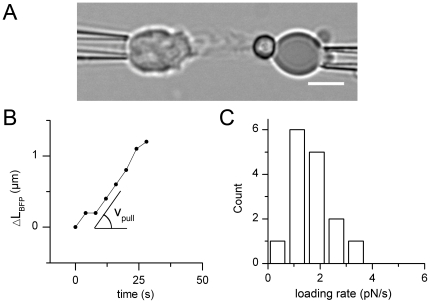
Characterization of the CD3-induced pulling phase.(A) During the pulling phase, the T cell protrusion pulls on the bead of
the force probe, leading to its elongation over time. Bar is 5 µm.
(B) elongation of the BFP
ΔLBFP(t) = LBFP
(t)−LBFP (0) in a representative experiment.
ΔLBFP increases initially at a constant speed
vpull = dLBFP (t)/dt. (C)
Distribution of the resulting loading rate
r = dF/dt (expressed in pN/s),
r = 1.6+/−0.2 pN/s for a probe stiffness
k = 50 µm/s (N = 15
cells).